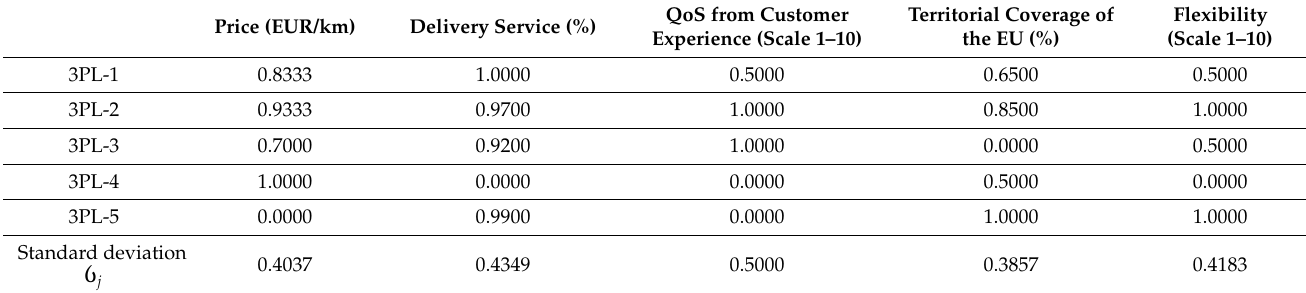
Table 7. Initial CRITIC decision-making matrix with standard deviations (Source: